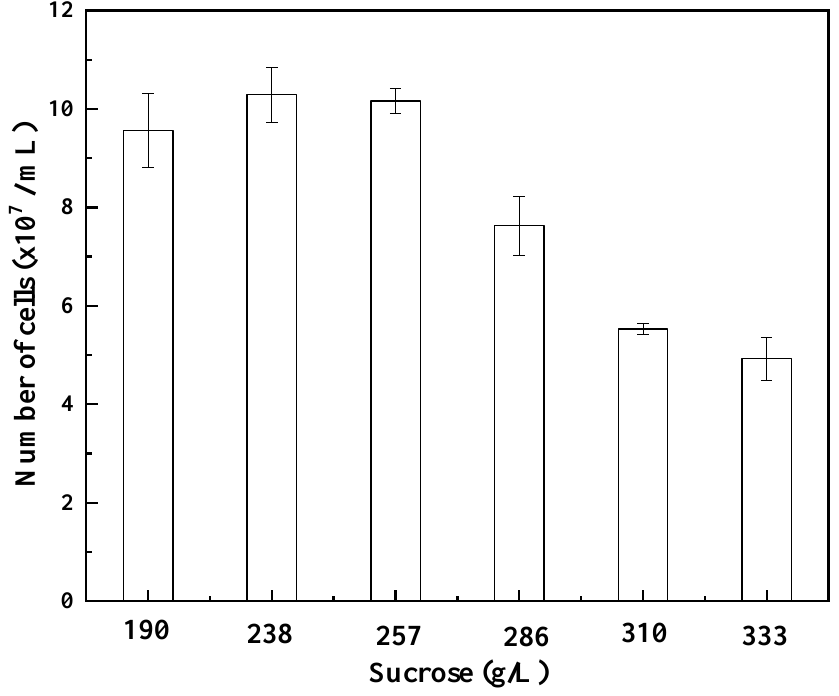
Figure 4. Effects of sucrose concentration on the growth of S. cerevisiae GJ2008. 3.3. Isolation of Mutant Strains by TTC and Py‑Fe3+ Triphenyl‑2H‑tetrazoliumchloride (TTC) reacts with yeast metabolites and is reduced by hydrogen into insoluble red tribenzoate (TTF) [22], which is a measure of cell vitality. Mutant yeast cells that could tolerate 381 g/L sucrose were diluted on the coating plate, TTC solution was added for initial screening, and 380 strains with the first and deepest reddening were selected for subsequent screening using the Py‑Fe3+ method. The 380 mutant strains were selected and cultured on 48‑well plates. Fermentation broth supernatant (120 µ L) and 80 µ L ferric nitrate (1 M) were reacted at room temperature for 10 min and OD 520 measurements were performed. A small number of strains had a significantly lower OD 520 value in the fermentation broth (Figure 5). The six strains (Shown by arrows in Figure 5) with the lowest OD 520 value were selected for shaking and the dominant NT‑F1 strain with the highest ethanol synthesis was obtained (Supplement Table S1). To verify the feasibility of this method, two OD 520 strains (NT‑FX and NT‑FY) with higher values were randomly selected for fermentation from the 380 strains, but their ethanol yield remained at about 80 g/L (Supplement Figure S5). The results illustrated that it is not accurate to rely solely on respiratory intensity as a screening mechanism and a more accurate screening method is necessary.